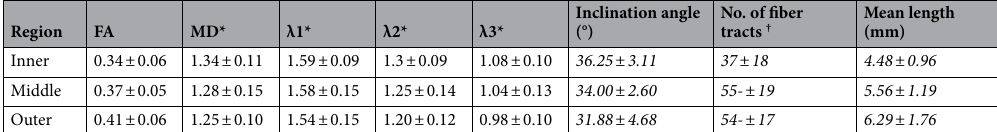
all tested parameters. The mean tractography extracted values for each of the samples are shown on the right side